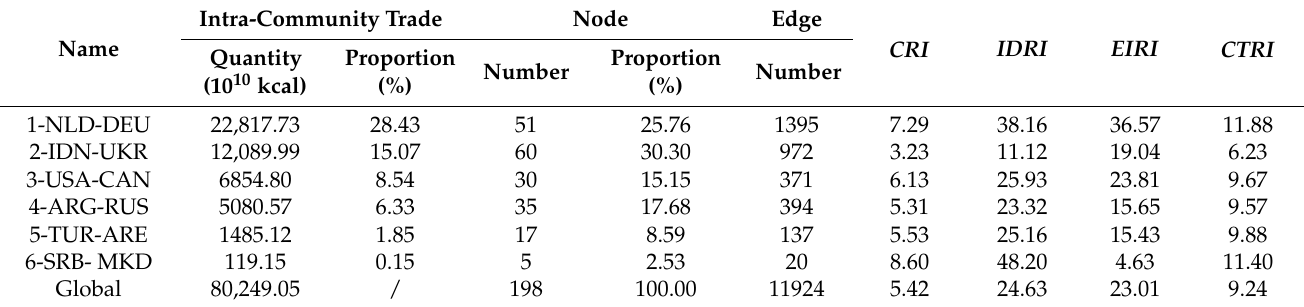
Table 4. Characteristics of the CCFTN community